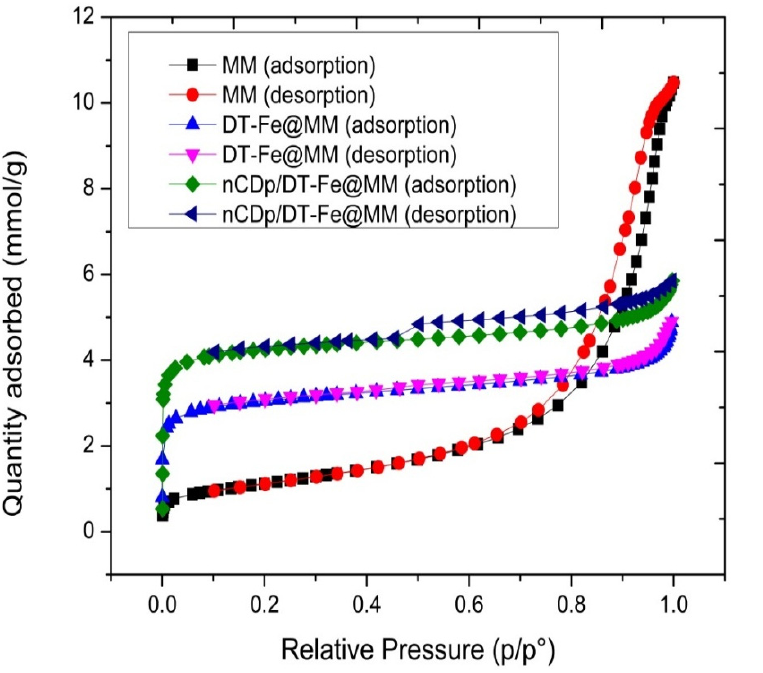
Figure 6. BET surface characterization result of unmodified montmorillonite (MM), doped titanium